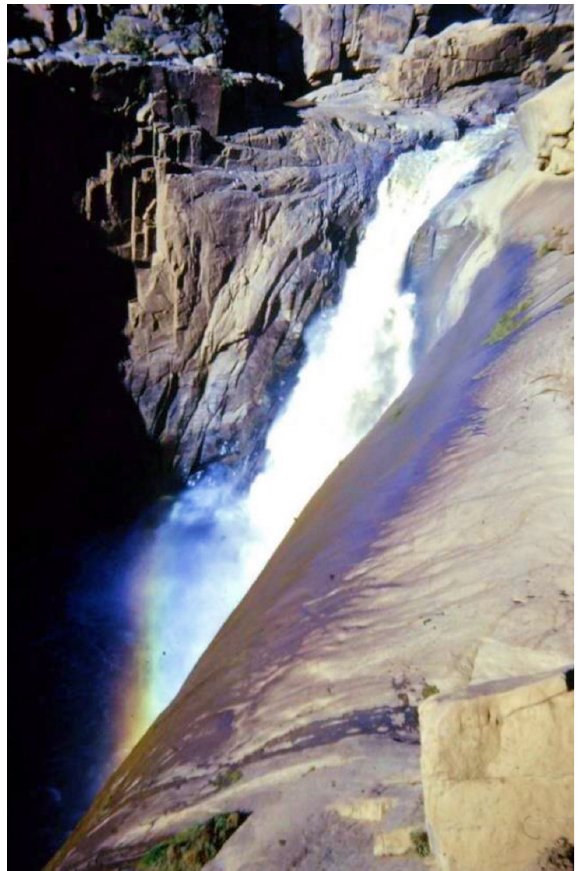
Fig. 3. The Augrabies Falls on the Orange River, South Africa. Photo: July 1968.